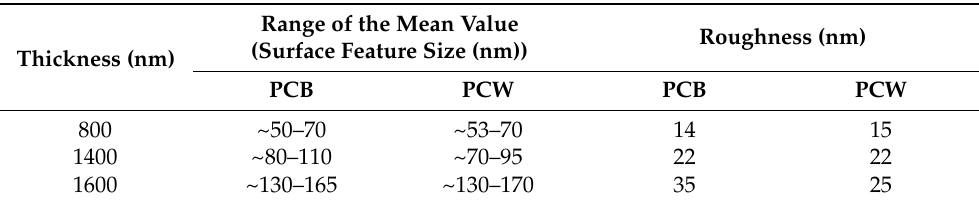
Table 1. Variation of surface feature size and roughness with thickness for PCB and PCW substrates (both parameters were calculated in a buckling-free